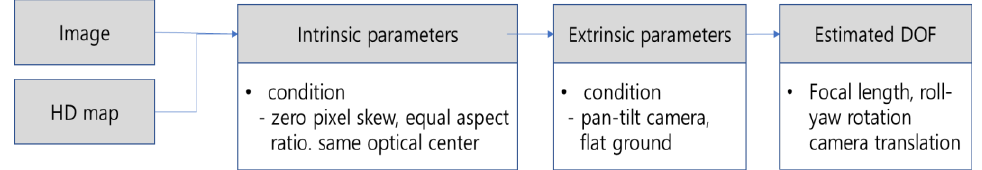
Figure 3. Data processing flowchart with estimated parameters.